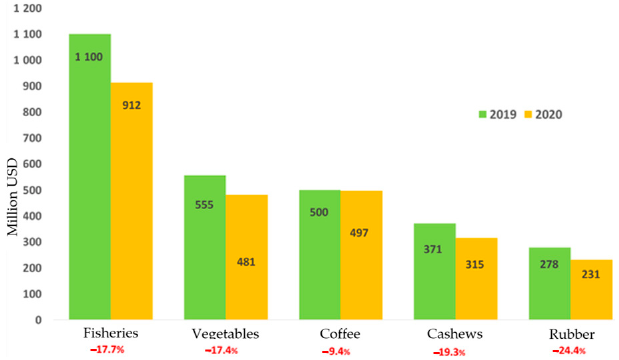
Figure 4. Vietnam’s total exports of agricultural products were affected by COVID–19 [3].